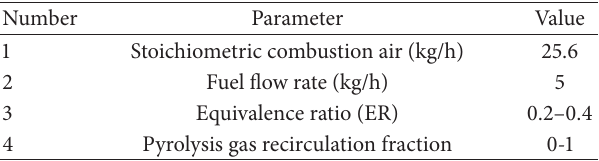
Table 4: Simulation parameters.